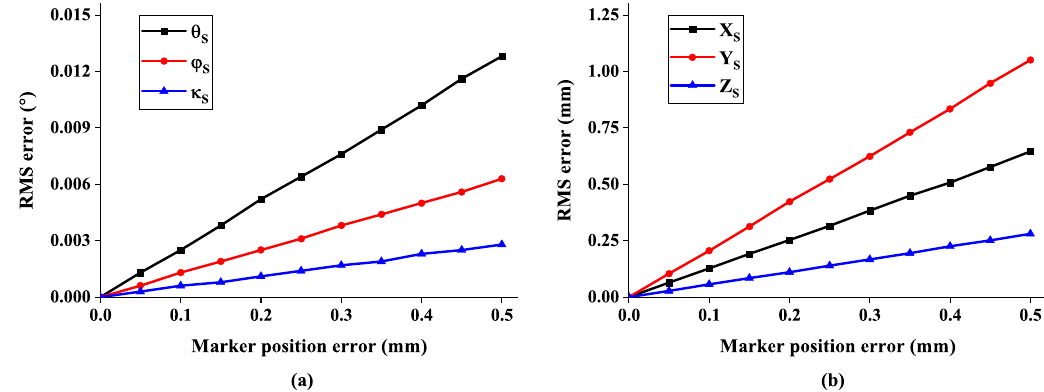
Figure 9. The root mean square (RMS) error of 6-DOF with respect to marker position error: ( a ) the error of rotation angle and ( b ) the error of system position.